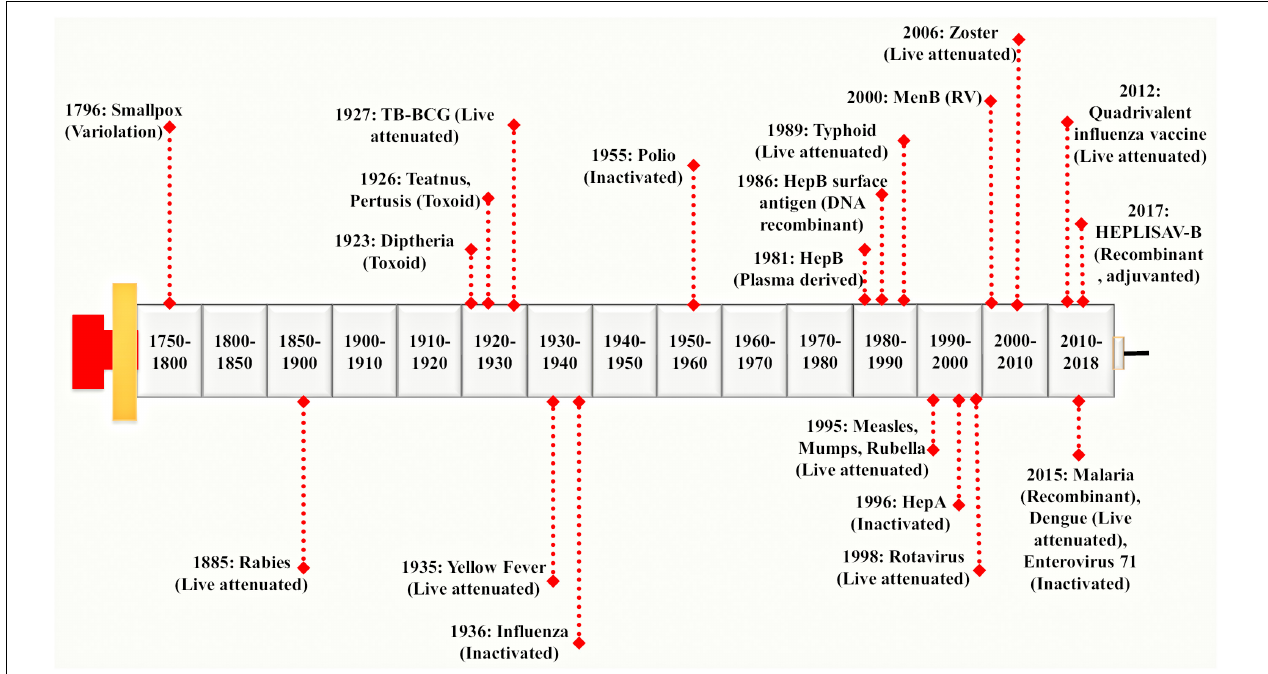
FIGURE 1 | Evolution of vaccine development processes: Vaccine development was pioneered by Edward Jenner. He discovered a working vaccine against small pox in 1796 derived by variolation and further work was continued by Louis Pasteur. He has discovered a live attenuated vaccine against Rabies virus in 1885 considered to be one of the 1st generation vaccines. It was followed by a genomic revolution and in the post-genomic era, mankind witnessed the modern sequencing techniques. In early 21st century, Rappuoli introduced Reverse Vaccinology (RV) approach which provided a foundation to the development of 2nd generation vaccines (Rappuoli et al., 2016). Since then, advances in various ‘omics-based’ approaches together with RV led to the development of a much more advanced 3rd generation of vaccines in the present times. Different vaccines derived from variolation, live attenuated, inactivated, toxoid, DNA recombinant have been shown in the timeline.